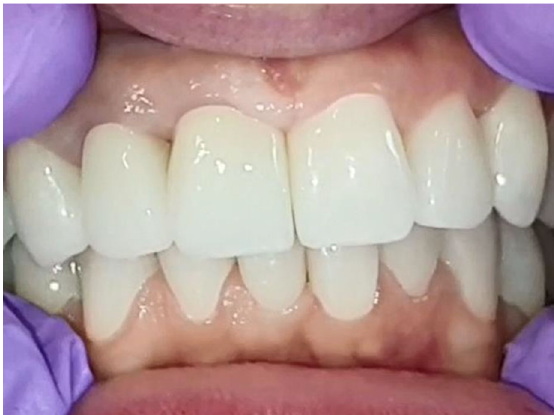
Figure 21. Upper and lower zirconia crowns.